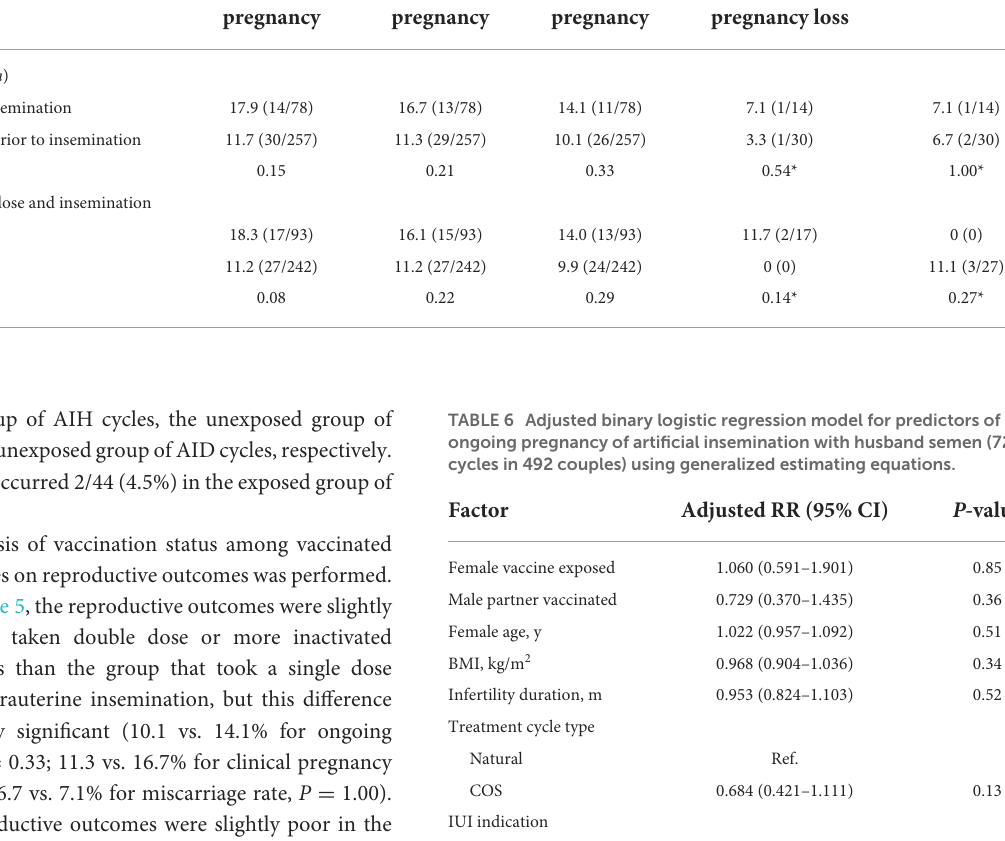
TABLE 5 Subgroup analysis of reproductive outcomes of artificial insemination with husband within exposed cycles. Biochemical Clinical Biochemical